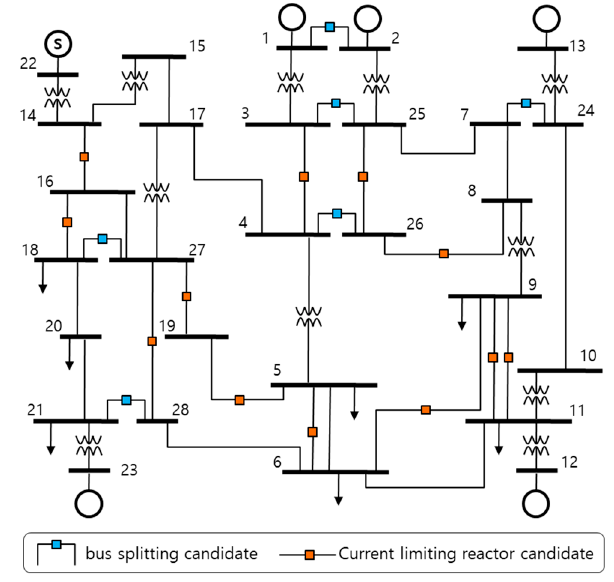
Figure 4. Modified 28-bus network. Table 2. Generators’ impedances with the machine bases.